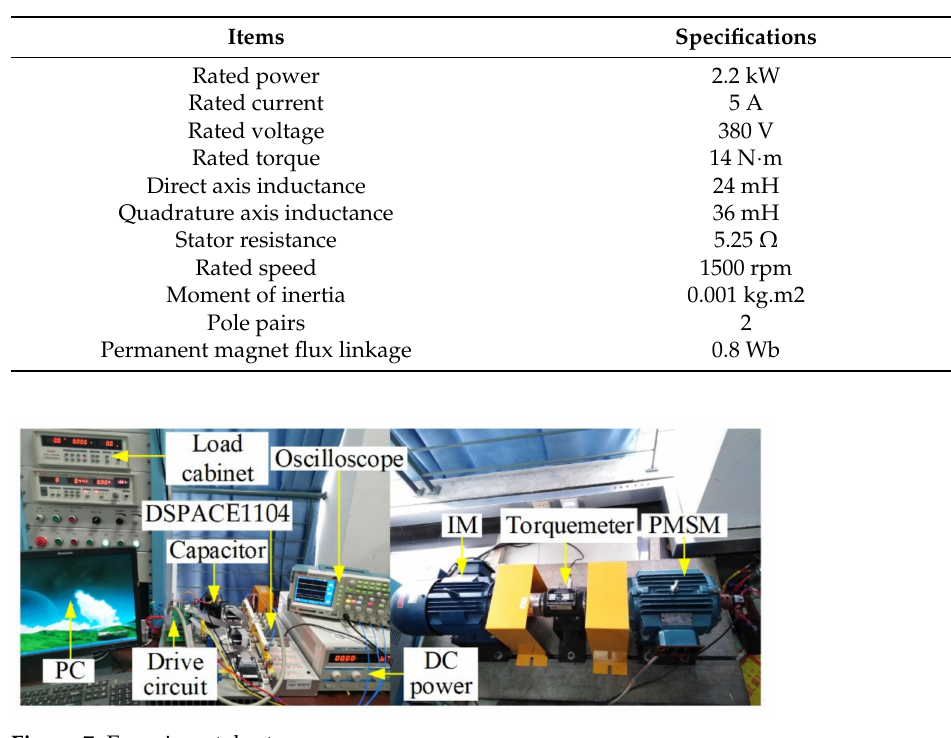
Figure 7. Experimental